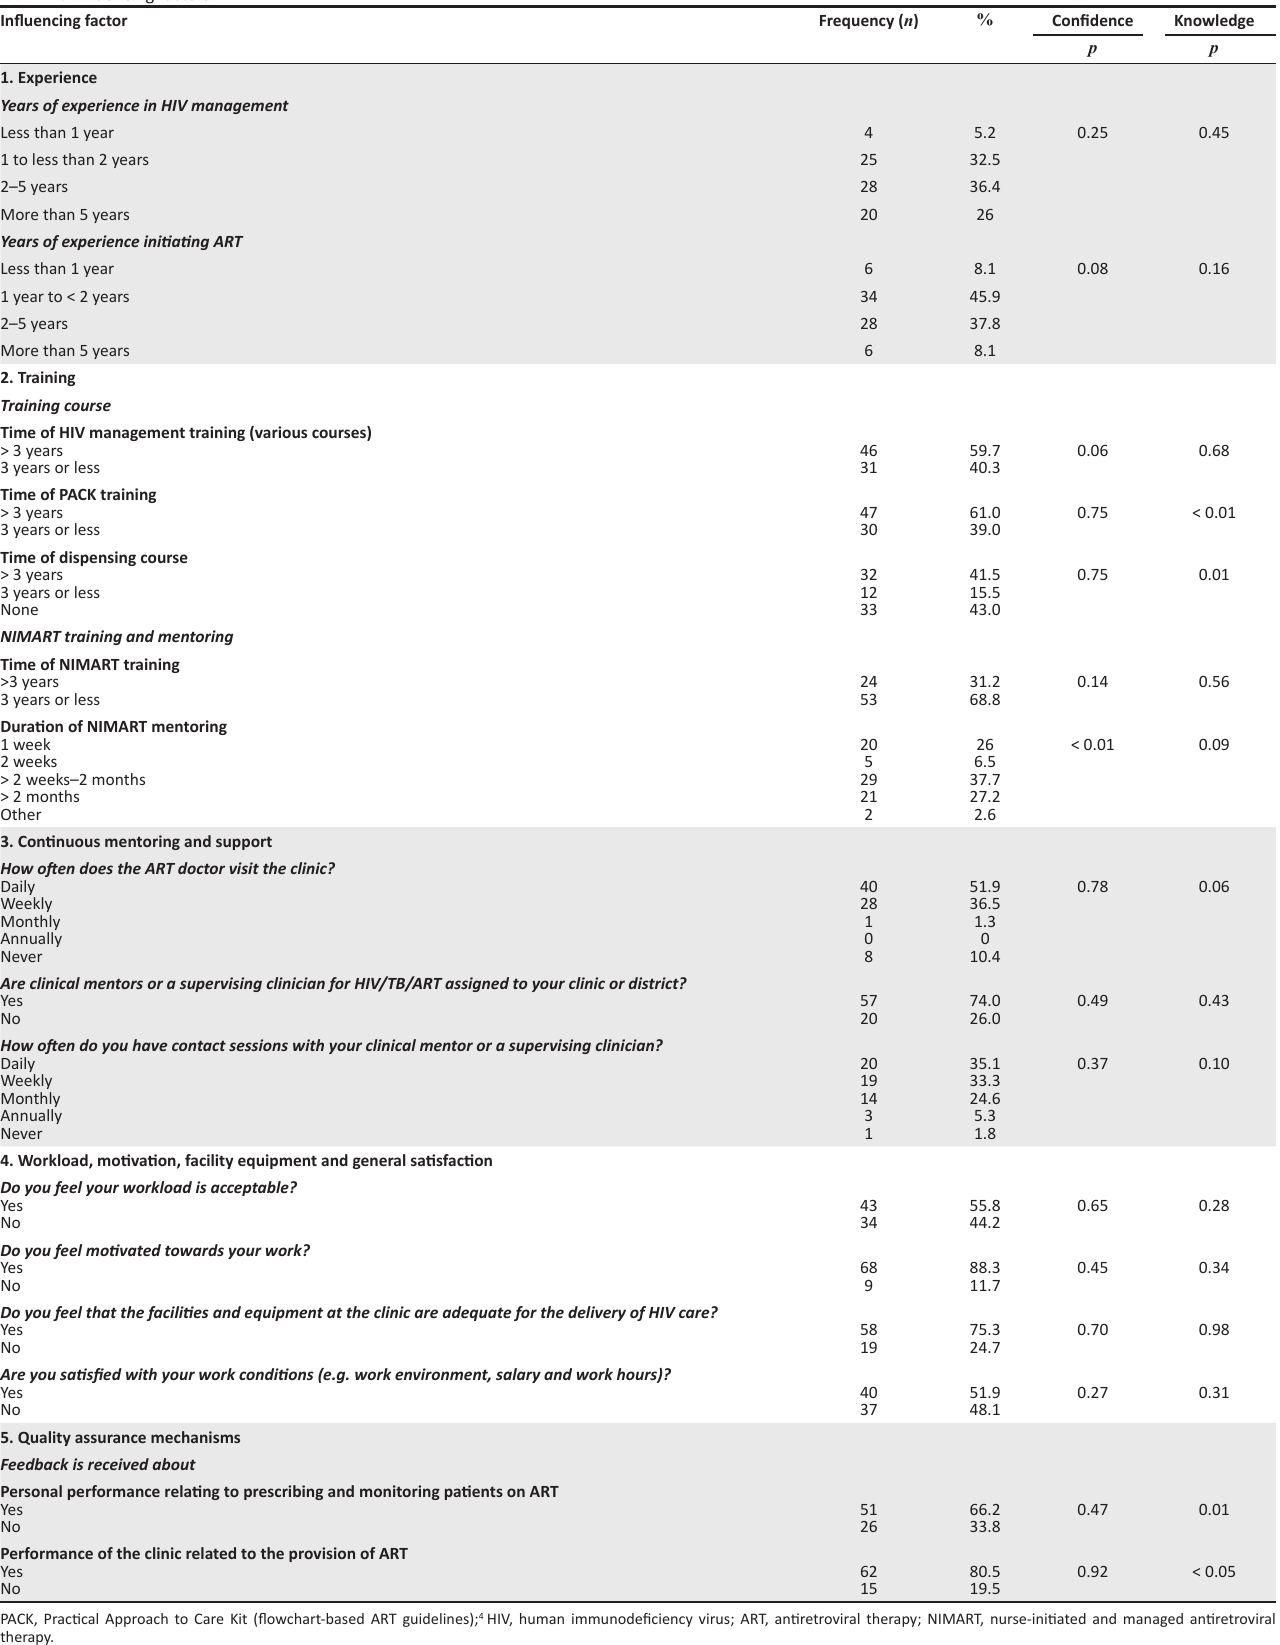
TABLE 2: Influencing factors. Influencing factor Frequency ( n ) % Confidence Knowledge